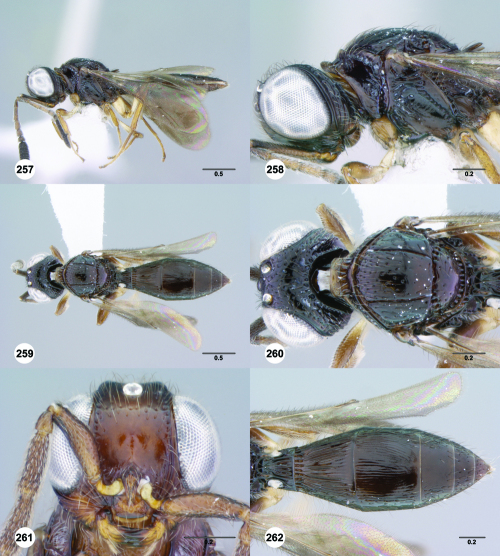
110Trichoteleia tahotra sp. n. 257 Lateral habitus, female (CASENT 2136058) 258 Head and mesosoma, lateral view, female (CASENT 2136058) 259 Dorsal habitus, female (CASENT 2136058) 260 Head and mesosoma, dorsal view, female (CASENT 2136058) 261 Head, anterior view, male (CASENT 2134151) 262 Metasoma, dorsal view, female (CASENT 2136058). Scale bars in millimeters.